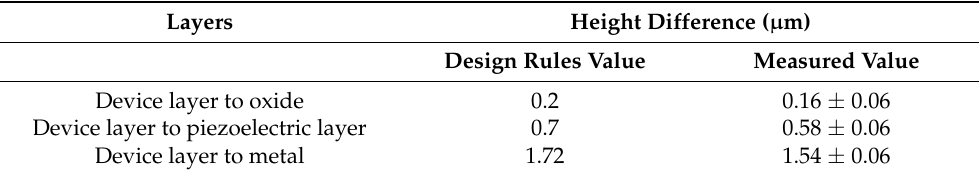
Table 1. Measured height di ff erences versus designed values.